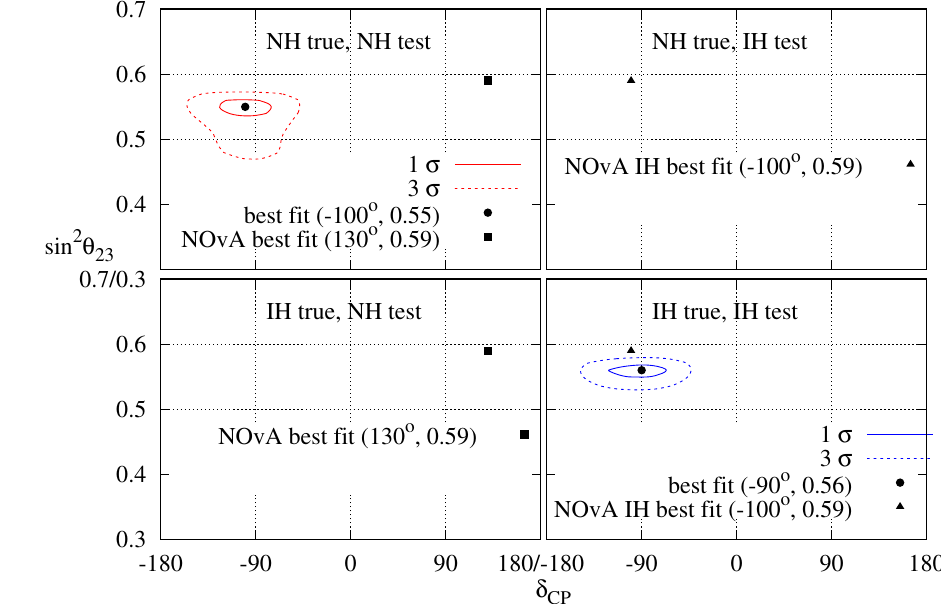
0.40.50.60.7 NH true, NH test 1 σ best fit (-100 o ,